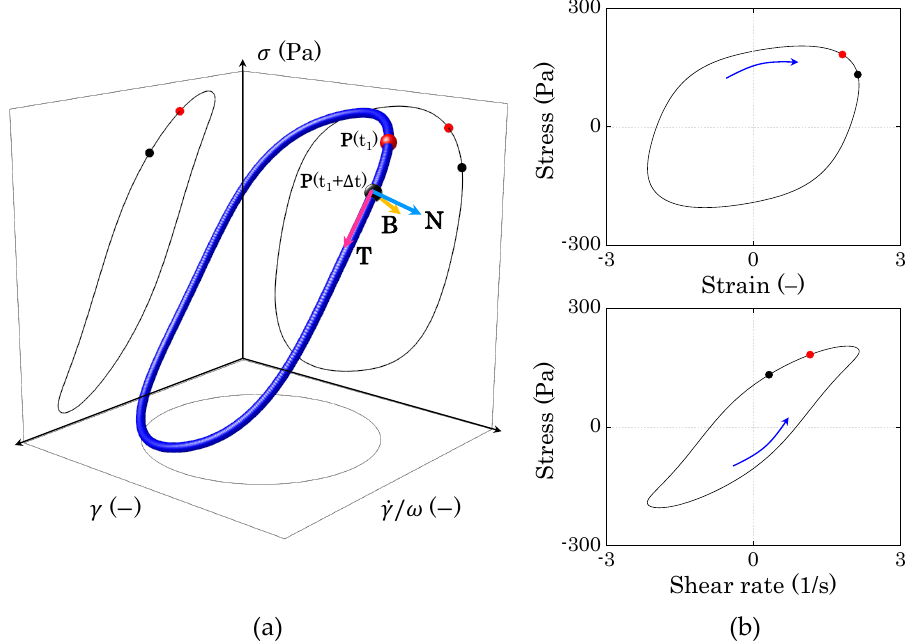
Figure 2. ( a ) Example of the nonlinear stress response to a periodic sinusoidal deformation reported in the three-dimensional space [ γ , ˙ γ / ω , σ ]. Each position vector P ( t ) on the curve can be identified through the Frenet–Serret components, as reported in figure. ( b ) Projections of the three-dimensional trajectory on the [ γ , σ ] and [ ˙ γ / ω , σ ] planes (Lissajous–Bowditch plots). The blue arrows indicate the orientation of the